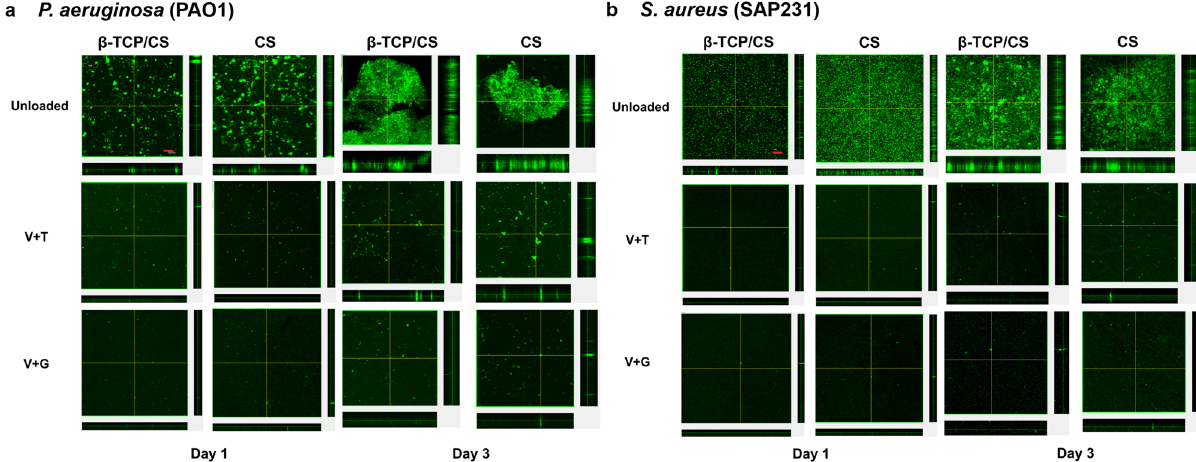
Figure 4. Prevention of P. aeruginosa PAO1 ( a ) and S. aureus SAP231 ( b ) biofilm formations on the glass surface of a MatTek tissue culture plate at days 1 and 3. Red scale bar (top left panel): 50